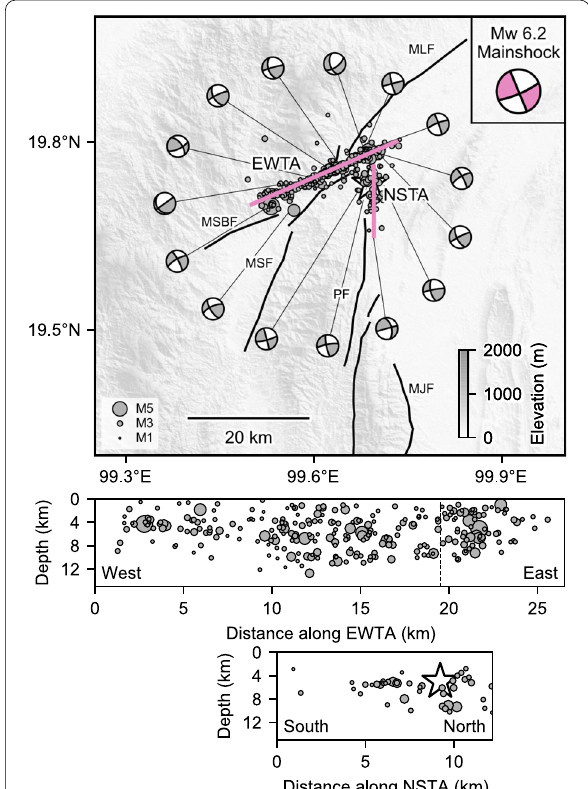
Fig. 2 The study area of the 2014 Thailand earthquake. The open star shows the mainshock hypocenter. The large beach ball shows the GCMT solution of the 2014 Thailand earthquake (Dziewonski et al. 1981; Ekström et al. 2012). The small beach balls show the focal mechanism of the relocated aftershocks with the moment magnitude larger than 4.2 (Pananont et al. 2017). The pink lines highlight the aftershock lineations of the NSTA and EWTA. The black lines are the active faults of the Phayao Fault Zone (DMR 2016; Kanthiya et al. 2019): MLF; Mae Lao fault, PF; Phan fault, MSF; Mae Suai fault, MSBF; Mae Suai Boundary fault, and MJF; Mae Jai fault. The topography is from SRTM15 (Tozer et al. 2019). The lower panel + shows the cross section of the aftershocks projected along the EWTA within – 4/ 10 km width across the projected track. The dashed + line denotes the projected location of the hypocenter. The bottom panel shows the cross section of the aftershocks projected along the NSTA within 3 km width across the projected track. The open star ± denotes the mainshock hypocenter (Pananont et al.